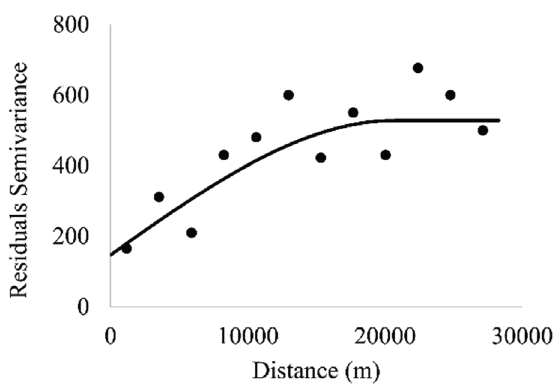
Figure 4 - Theoretical and experimental univariate semivariogram for wood volume residuals (m 3 /ha) as a function of environmental variables in Cerrado Sensu Stricto of the state of Minas